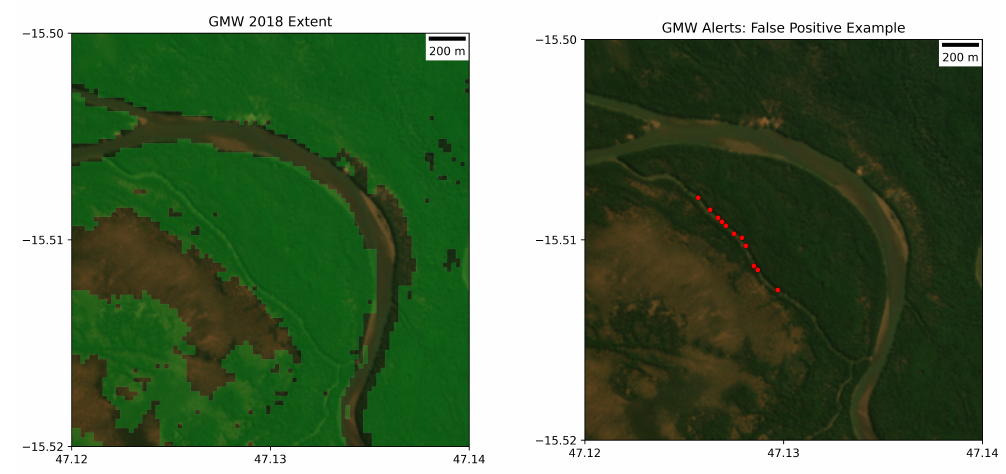
Figure 11. Illustrating a common cause of commission errors within the results from the mangrove loss alerts system, where the 2018 refined baseline (green regions) has not captured small river channels and, therefore, false positives (red points) for mangrove loss alerts are identified (Image courtesy: Planet Labs/NICFI).